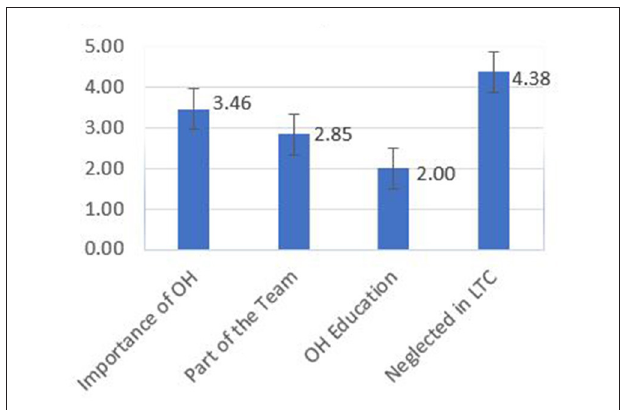
FIGURE 1 | Initial survey